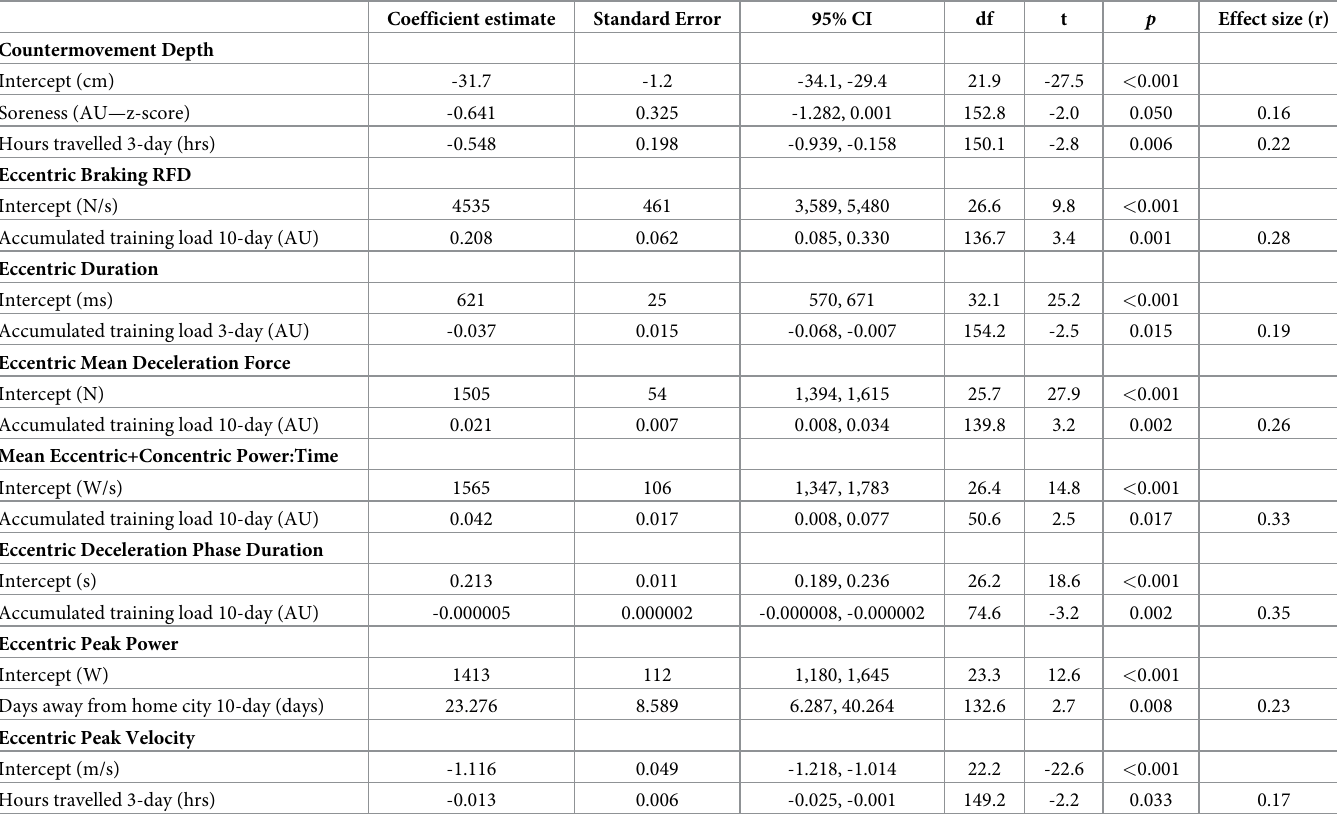
Table 6. Simple effects for countermovement jump